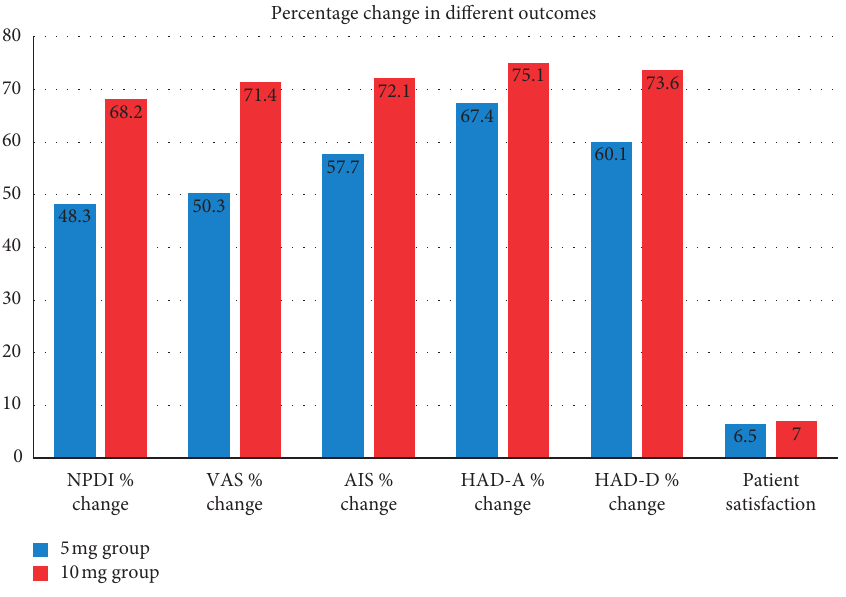
Figure 2: Changes in outcome measures following treatment with amitriptyline. Table 3: Outcomes of patients with chronic neck pain treated with 5 and 10mg